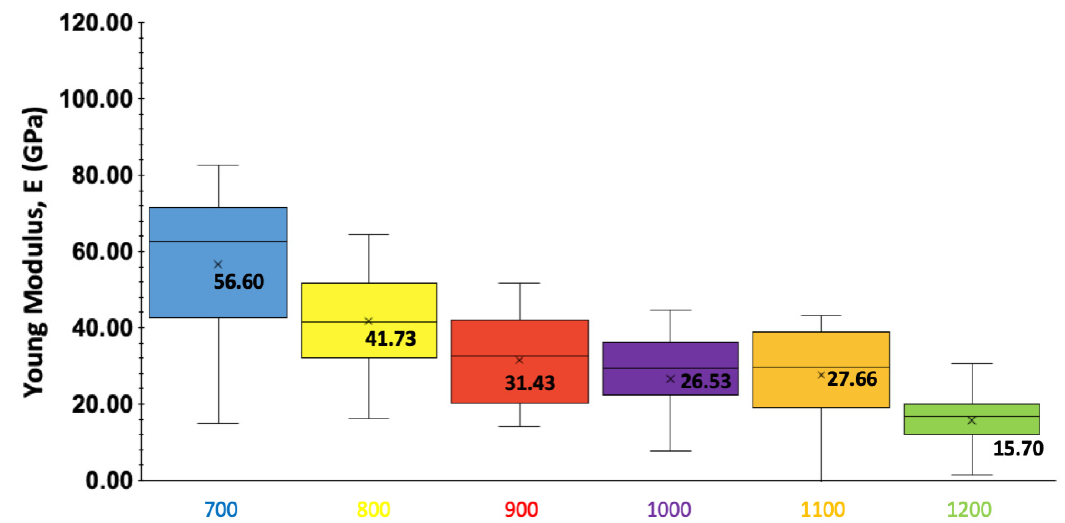
Figure A2. Slope and four ‐ point moving average values in elastic region in GPa.